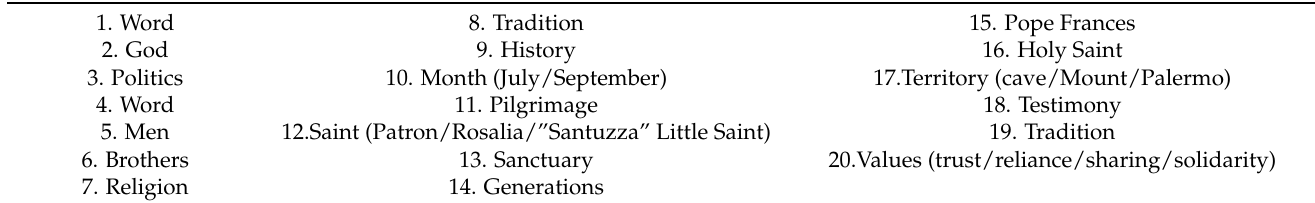
Table 1. NVivo made it possible to analyse terminological frequencies by means of procedures called Query and Word Frequency